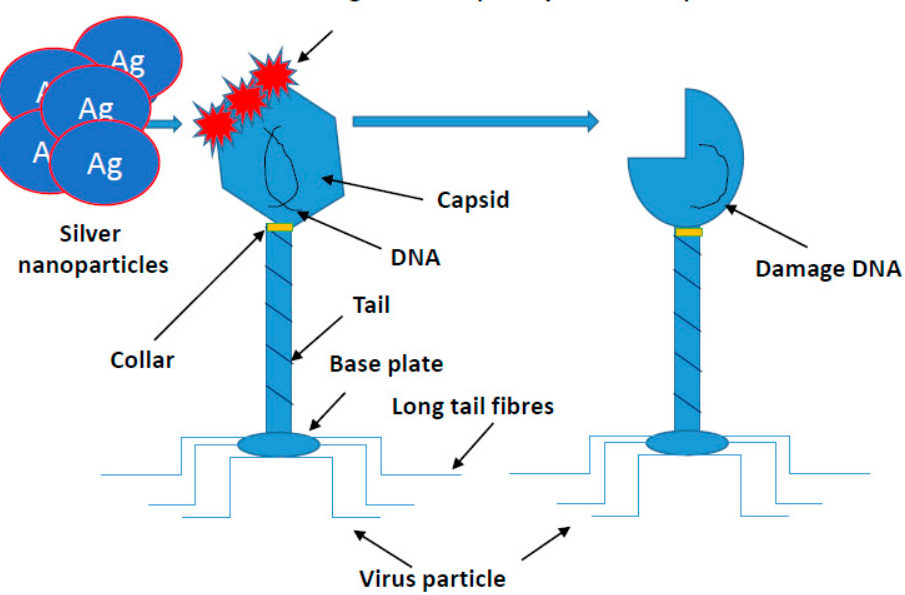
Figure 4. Mechanism of silver nanoparticles action on viruses’ structure. All viruses replicate through a similar sequence of events. AgNPs-based viral vaccines can be very effective against HIV-1, malaria, hepatitis B syncytial respiratory virus, HSV-1, monkey pox virus, influenza virus and Tacaribe virus.